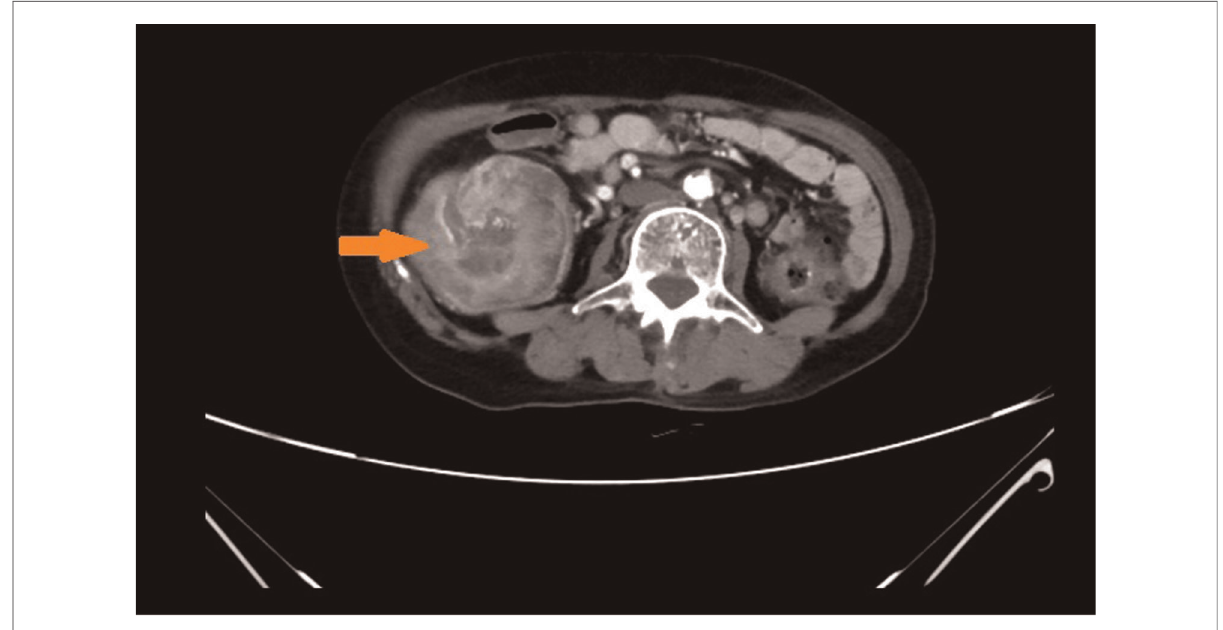
FIGURE 1 Computed tomography revealed ascending colonic